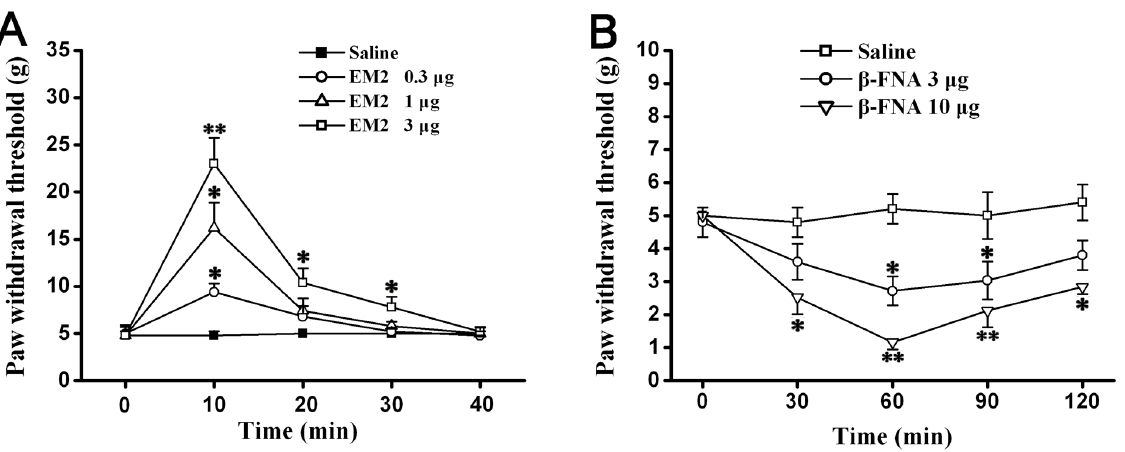
Figure 4. Decreased spinal EM2 contributed to mechanical allodynia in vincristine treated rats. (A) In Vincristine group, intrathecal injection of EM2 significantly attenuated the allodynia in a dose-dependent manner. (B) In Vincristine group, intrathecal administration of the mu- opioid receptor antagonist b -FNA made the mechanical allodynia more serious. *P , 0.05, **P , 0.01 vs. Saline group.